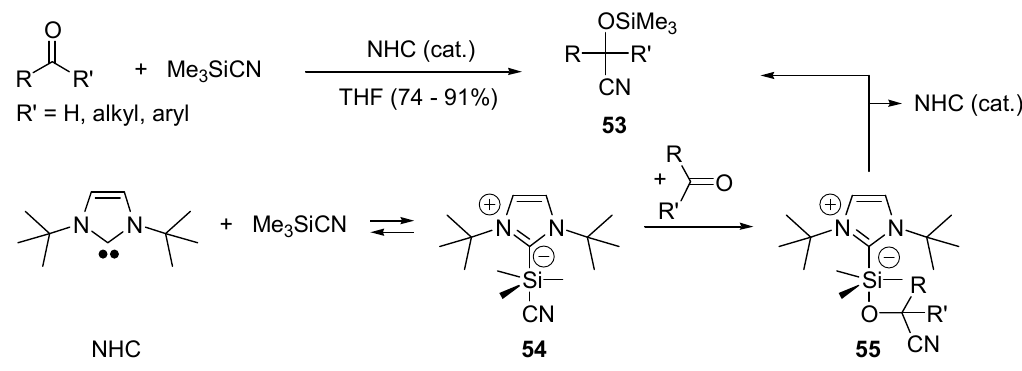
Scheme 28. NHC ‐ catalyzed cyanosilylation of aldehydes and ketones.